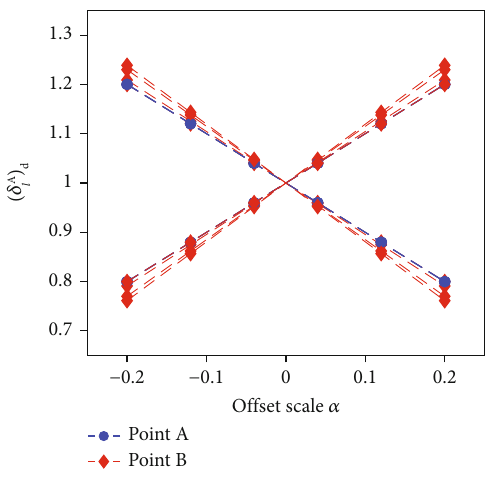
Þ ff erent l d with di